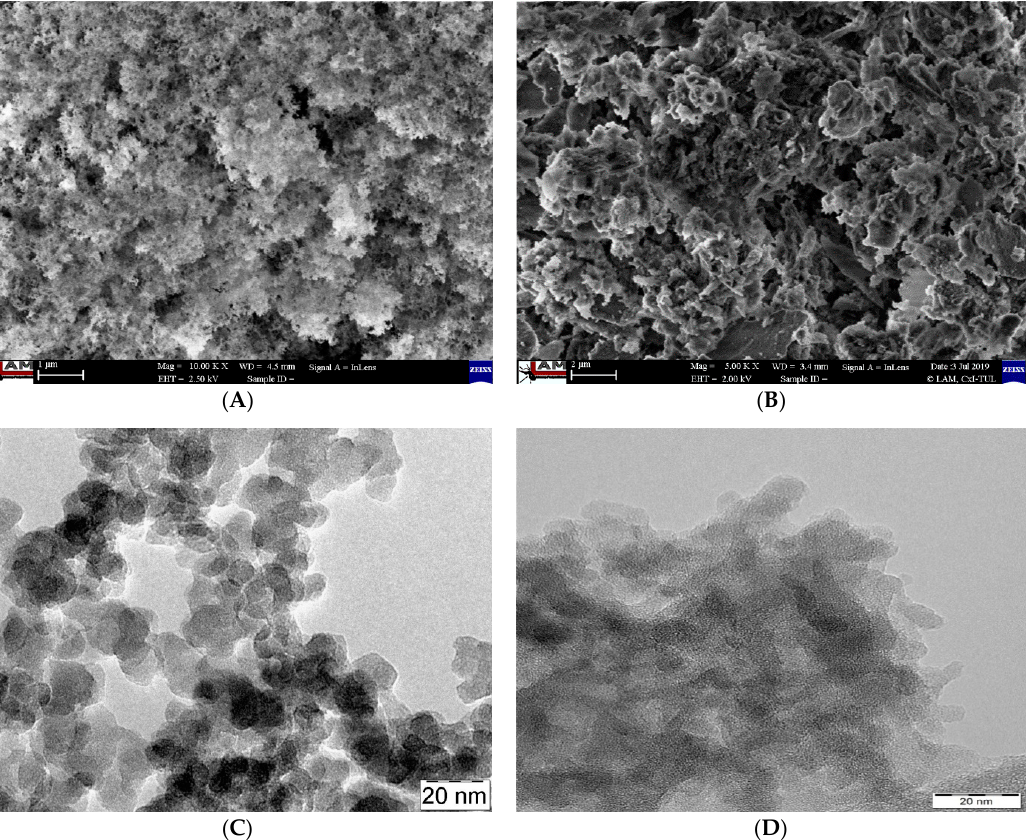
Figure 1. Characterization of silica nanoparticles. Silicon dioxide NPs (( A )— pyr SiO 2 and ( B )— bio SiO 2 ) were characterized by a scanning electron microscope (SEM). Analysis with SEM indicates that SiO 2 nanoparticles in form of the dried powders have a tendency to form agglomerate structures. Transmission electron microscopy (TEM) (( C )— pyr SiO 2 and ( D )— bio SiO 2 ) was used to determine the shape and size of the nanoparticles.